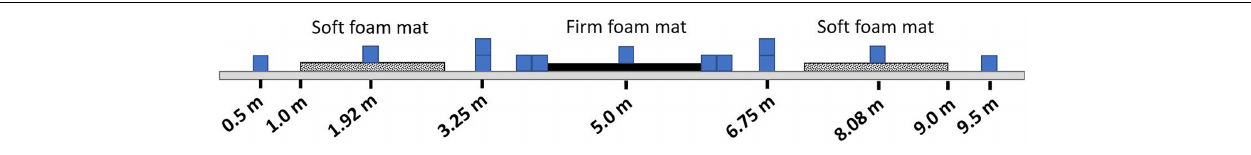
FIGURE 1 | Complex terrain walking course. Participants walked over a 10-meter course consisting of nine foam obstacles and three foam mats. This illustration shows terrain placement, but the exact dimensions of the obstacles and mats are not drawn to scale.